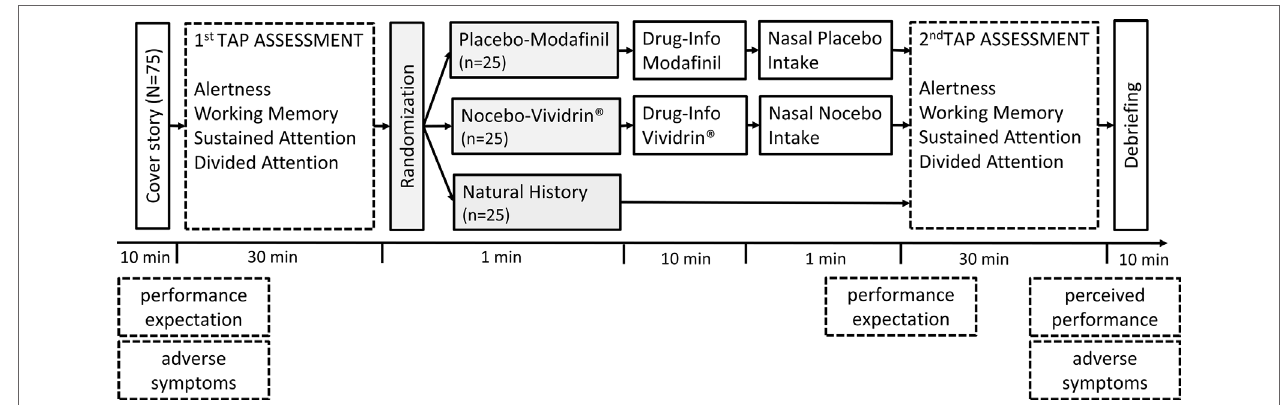
FIGURE 1 | Study design (see Methods for details) and outcome measurements (dashed frames) for the placebo–Modafinil ( n = 25), nocebo-Vividrin ® ( n = 25), and natural history ( n = 25) condition; TAP, Test of Attentional